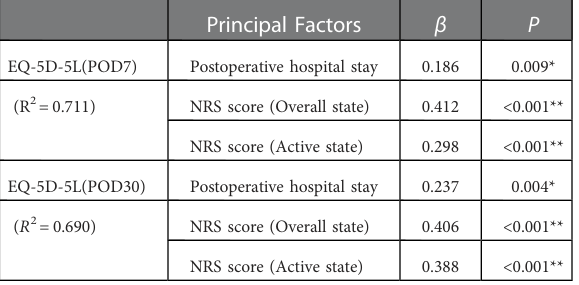
TABLE 5 Analysis of principal factors affecting EQ-5D-5L score at 7th and 30th days after surgery.